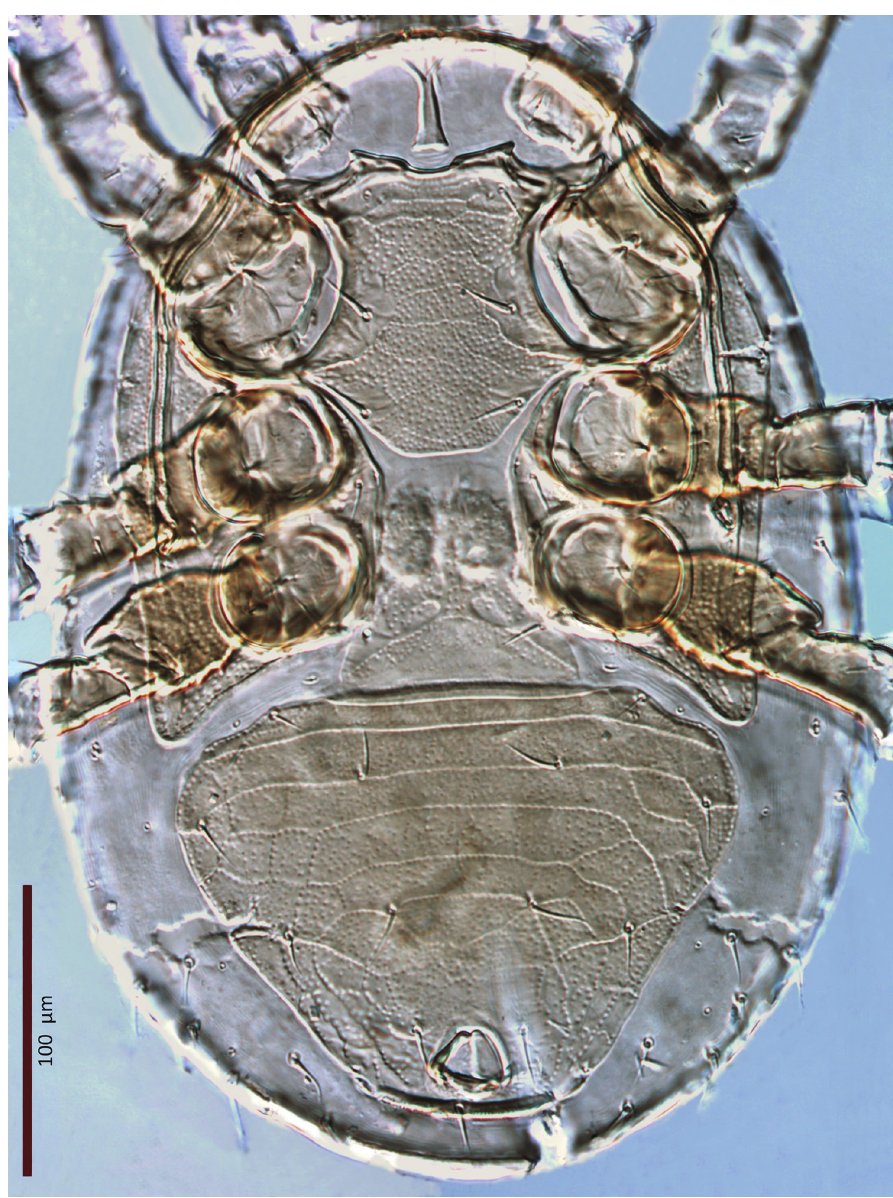
Figure 33. Zygoseius lindquisti sp. n., female, ventral idiosoma.